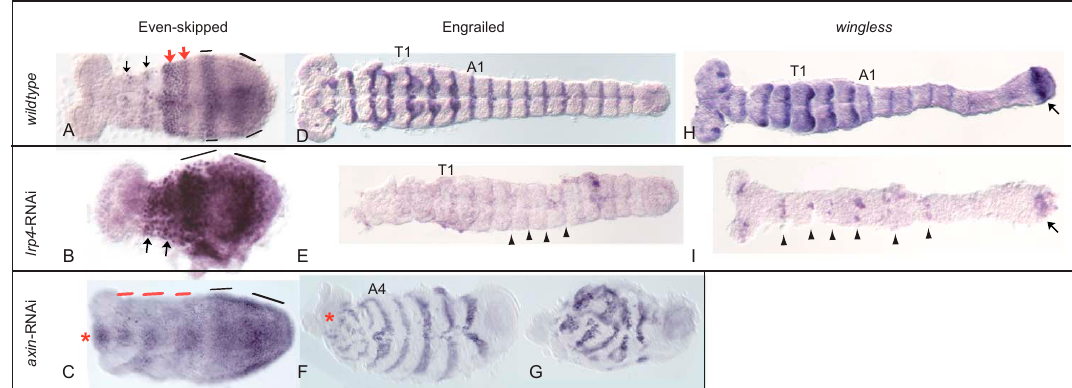
Figure 4. Analysis of segmentation genes in Tc-lrp4 and Tc-axin RNAi -embryos. Preparation of fixed embryos. ( A , D , H ): wild-type embryos; ( B , E , I ): Tc-lrp4 RNAi -embryos; ( C , F , G ): Tc-axin RNAi -embryos. ( A ) Expression of the pair-rule gene Even-skipped (antibody staining). In the wild-type, two broad domains that represent the double-segmented phase are seen in the growth-zone (bars). The split into segmented stripes starts just anterior to the growth-zone (red arrows). The first two segmental eve stripes are about to dissolve (black arrows). ( B ) Tc-lrp 4-RNAi: Eve expression is stronger when compared to the wild-type and hence, single stripes are hardly visible. ( C ) Tc-axin -RNAi: broad domains (black bars) in the growth-zone appear but do not dissolve into segmental stripes; instead, block-shaped domains in the region where the mesoderm forms are visible (red bars). Ectopically, Eve-positive cells are visible in a medial, anterior position (red star). ( D ): Fully segmented wild-type embryo. Engrailed expression demarcates the posterior segmental border. ( E ): Tc-lrp 4-RNAi: headless embryo lacking clearly identifiable En-stripes but with clearly visible segmental grooves (see arrowhead for examples). ( F , G ) Tc-axin -RNAi: scrambled En stripes at the anterior part of the embryos (red star in ( F )). No polarity information is recognizable. ( H ) Tc-wingless ( wg )/ Wnt1 expression (in-situ-hybridization) in the wild-type undergoing axis elongation. ( I ): Tc-lrp 4-RNAi: remnants of wg positive cells are visible in the segmental pattern (arrowheads). Posterior wg domain (arrow) seems weaker than in the wild-type but is clearly visible.